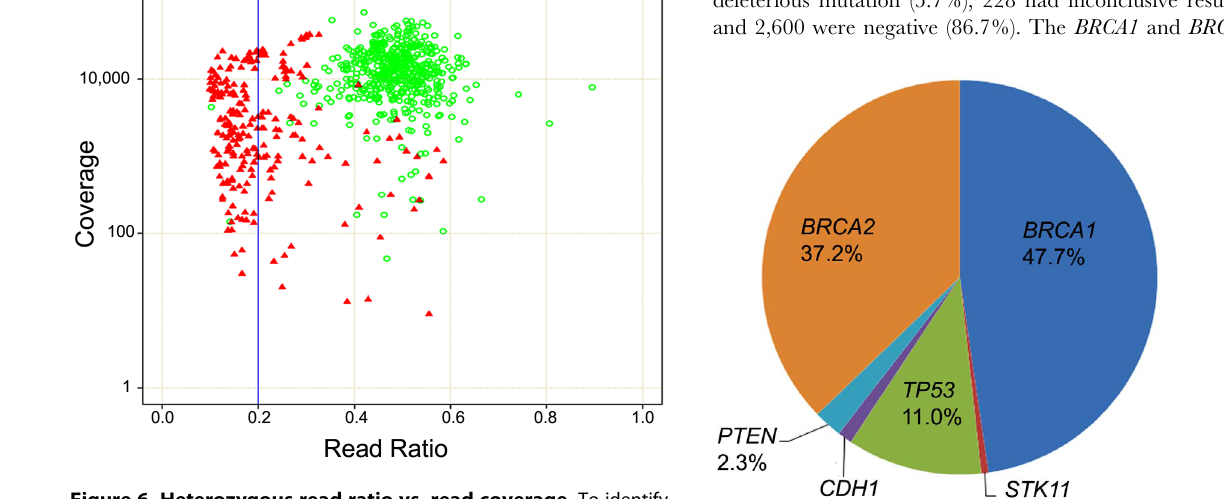
Figure 6. Heterozygous read ratio vs. read coverage. To identify the profile of false positives, sequencing coverage was plotted against the heterozygous read ratios using Sanger sequencing confirmed NGS variants. Green circle, Sanger confirmed variants. Red triangle, Sanger cleared false positive.